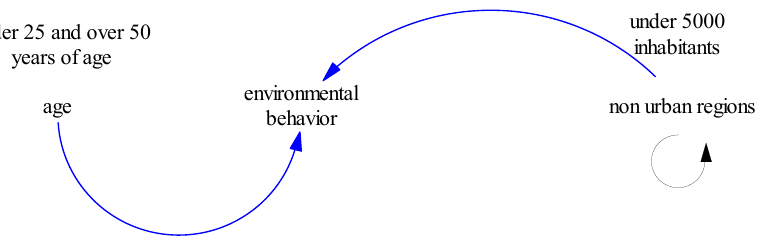
Figure 1. Factors affecting positively the environmental behavior of both dentists and dental stu- dents.